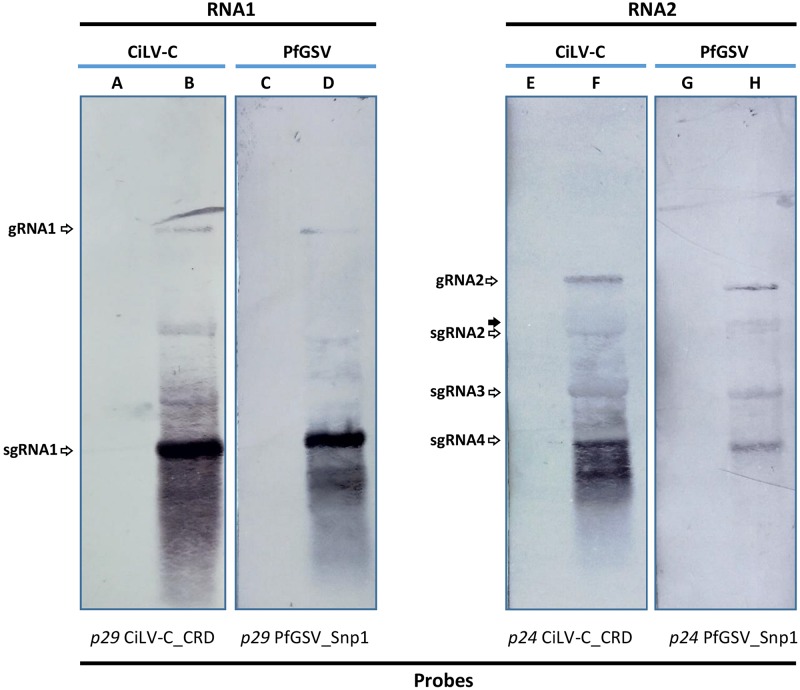
Passion fruit green spot virus RNA’s profile in infected plants. Northern blot hybridization using 10 μg of total RNA extracts from PfGSV-infected passion fruit plant (D,H), which was compared with that of CiLV-C in sweet orange plant (B,F). Digoxigenine (DIG-11-dUTP)- labeled probes were individually generated by PCR using specific primers for p29 and p24 ORFs from CiLV-C isolate CRD and PfGSV isolate Snp1. In lanes A and C, and E and G 10 μg of total RNA extracts from healthy sweet orange and passion fruit plants were assayed, respectively. The solid arrow indicates a band in the lane H that may correspond to sgRNA molecules for the putative expression of P13 protein.